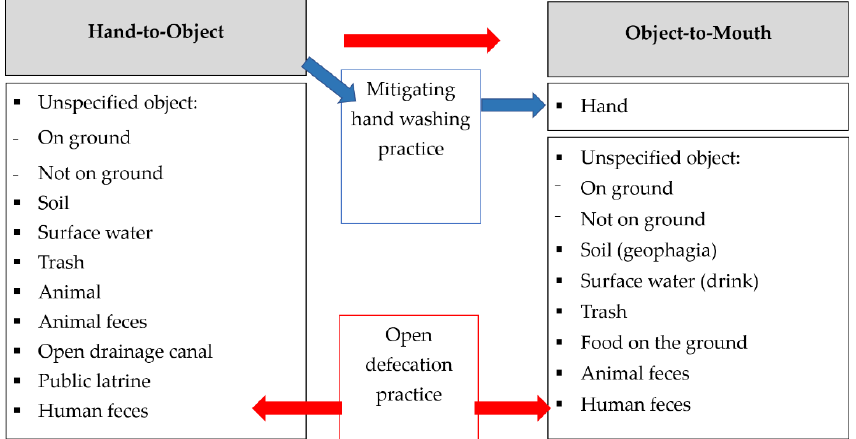
Figure 1. Conceptual framework for children’s contact with objects and hygiene and sanitation practices at public sites. Red arrows represent flow of feces into the environment and children’s mouths. Blue arrows represent behavior that would reduce feces transmission.